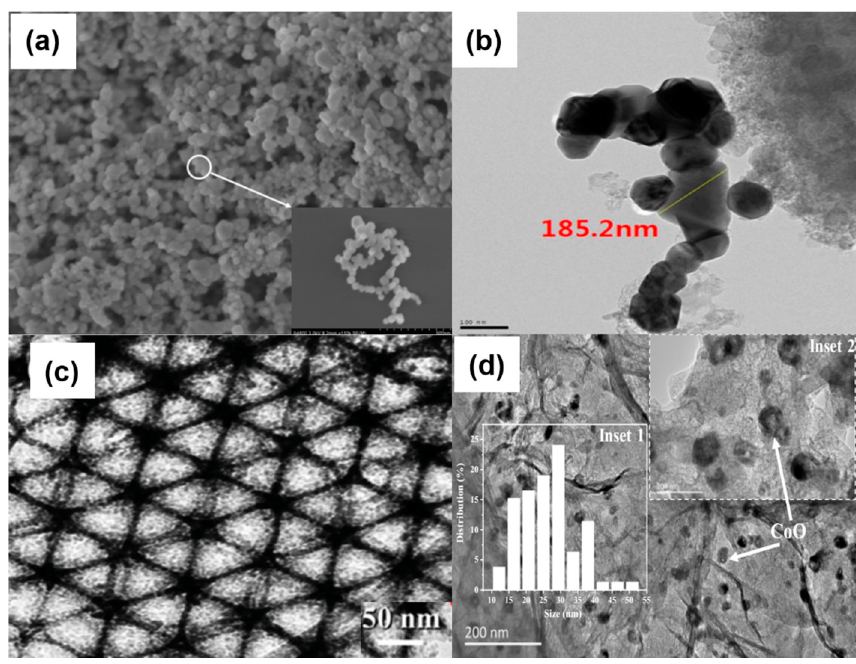
Figure 7. ( a ) SEM images of Mn 3 O 4 /MnO nanoparticles [33] (Copyright © 2019, Elsevier), ( b ) TEM images of LaCoO 3 catalysts [34], ( c ) TEM image of honeycomb-like 3D ordered mesoporous spinel Co 3 O 4 [35] (Copyright © 2016, John Wiley and Sons), ( d ) TEM image of hollow cobalt oxide nanoparticles [36] (Copyright © 2019, Elsevier).